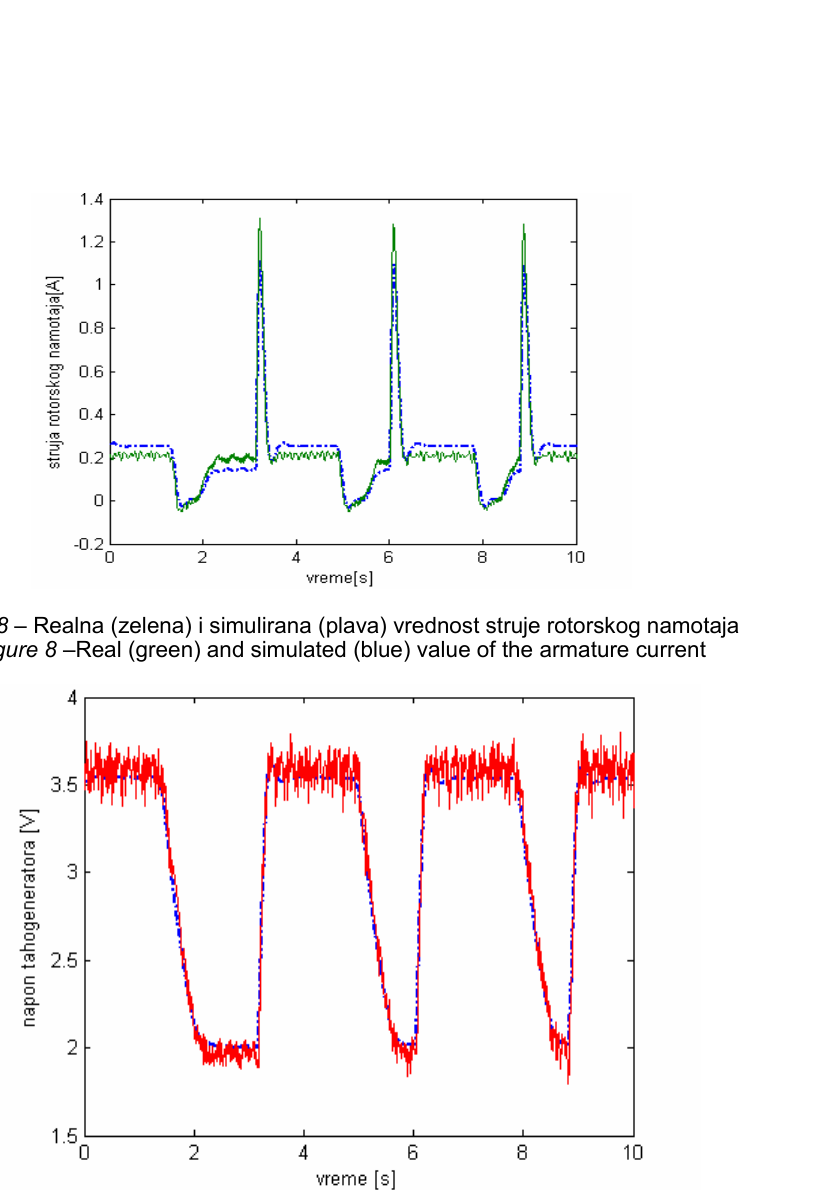
Figure 9 – Real (red) and simulated (blue) value of the tahogenerator voltage Zaklju č ak U radu je prikazan jedan postupak identifikacije parametara modela jednosmernog motora u prostoru stanja. Jednosmerni motor je u opštem slu č aju sistem drugog reda. Me đ utim, motor se može predstaviti pomo ć u dva podsistema prvog reda: elektri č nog i mehani č kog. Snimanjem